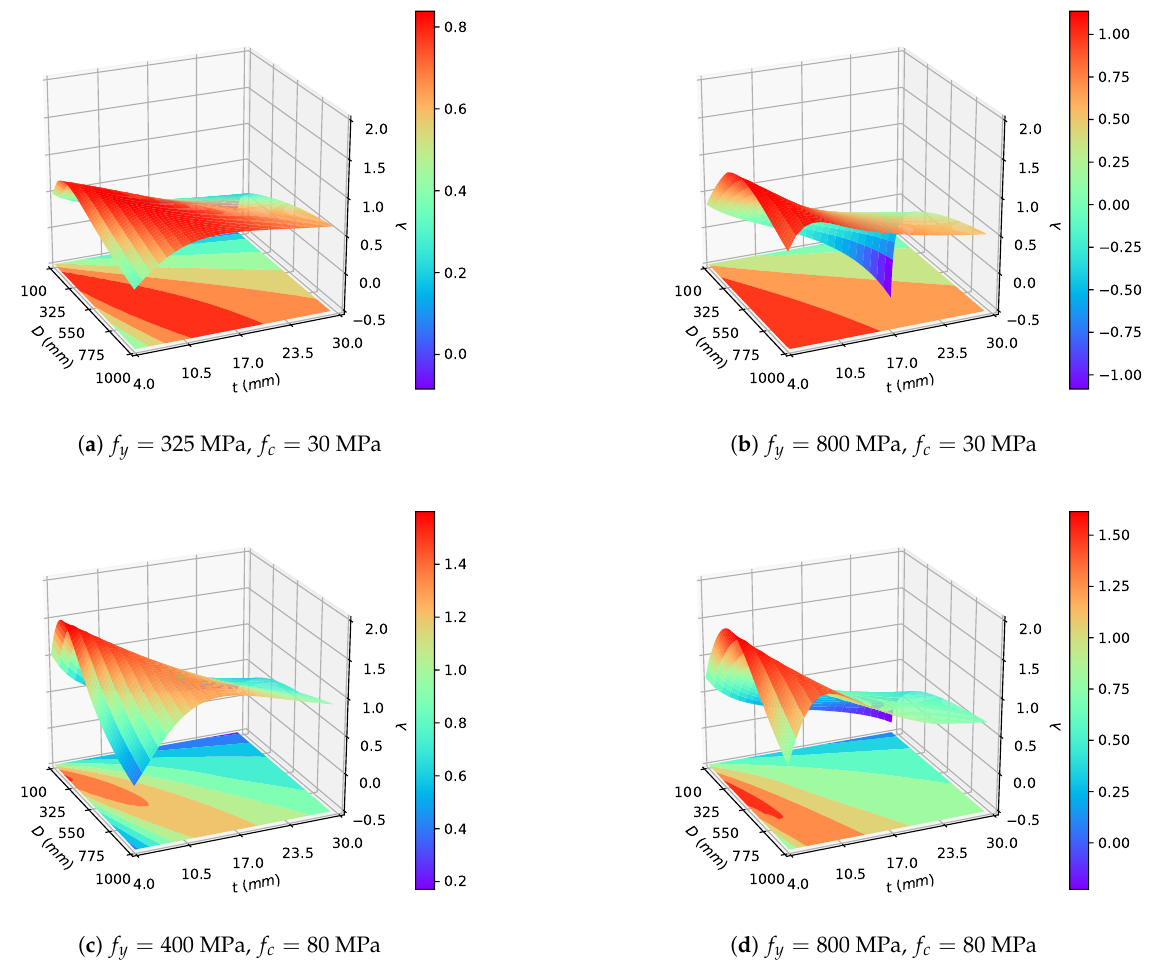
Figure 17. Variation in the composite ratio λ with different dimensions.